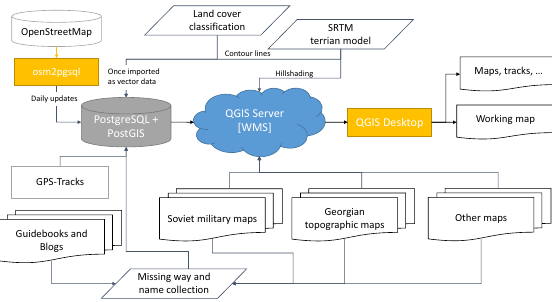
Figure 1. Parts of the WMS for the mapping project show the implemented geodata integration into the service.